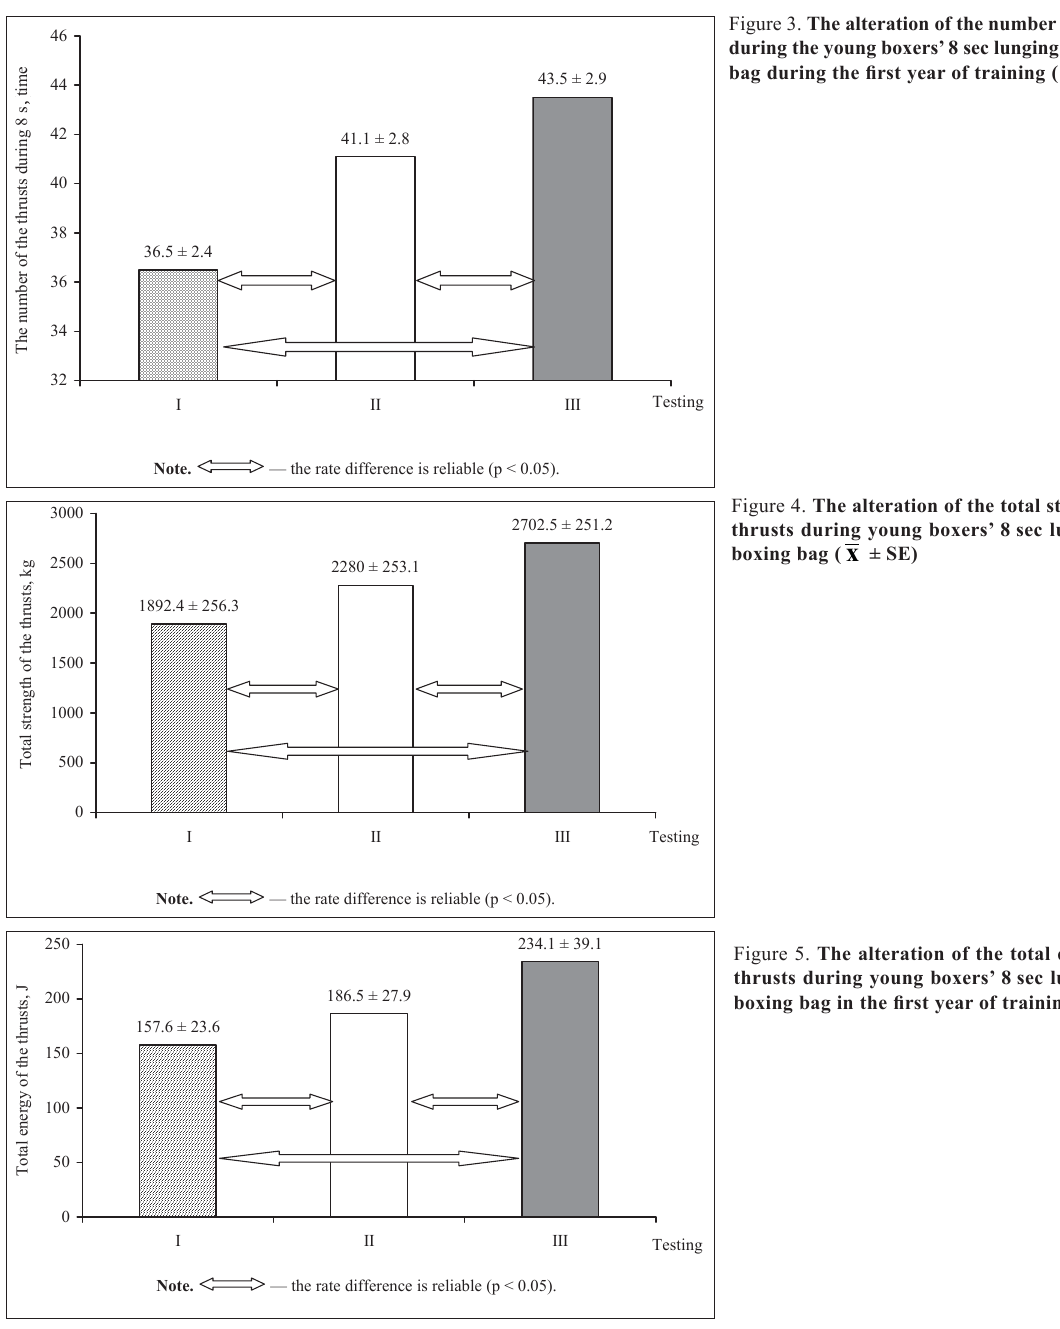
Figure 4. The alteration of the total strength of the thrusts during young boxers’ 8 sec lunging to the boxing bag ( x ± SE)